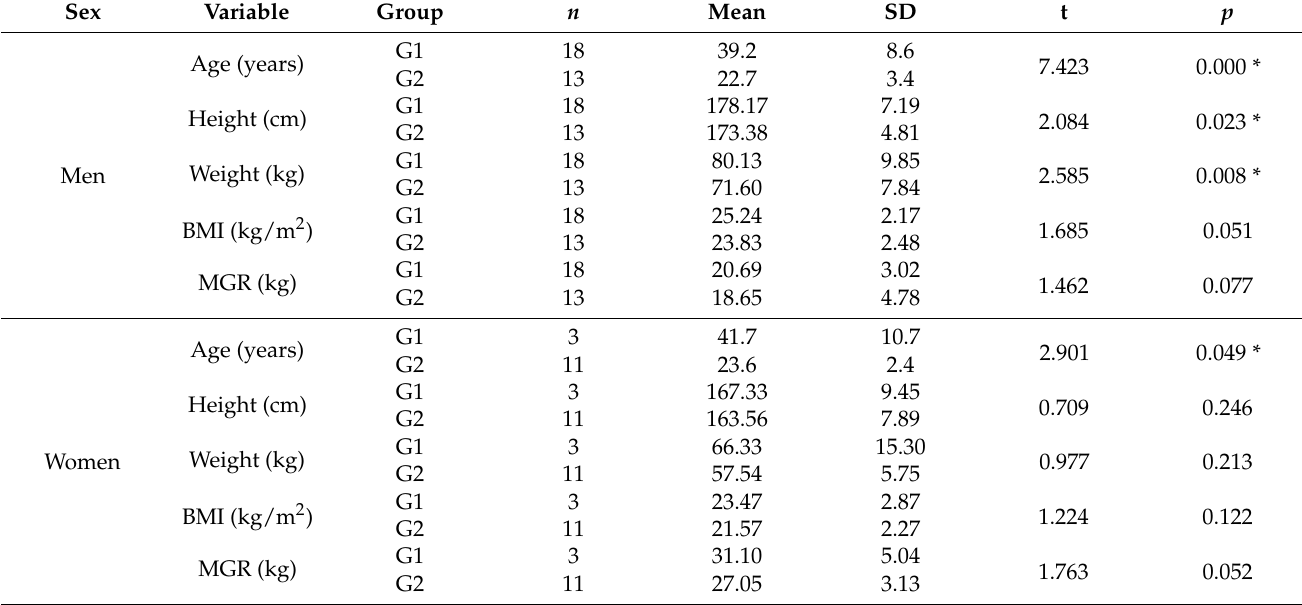
Table 1. Anthropometric and body composition characteristics divided by sex and group.